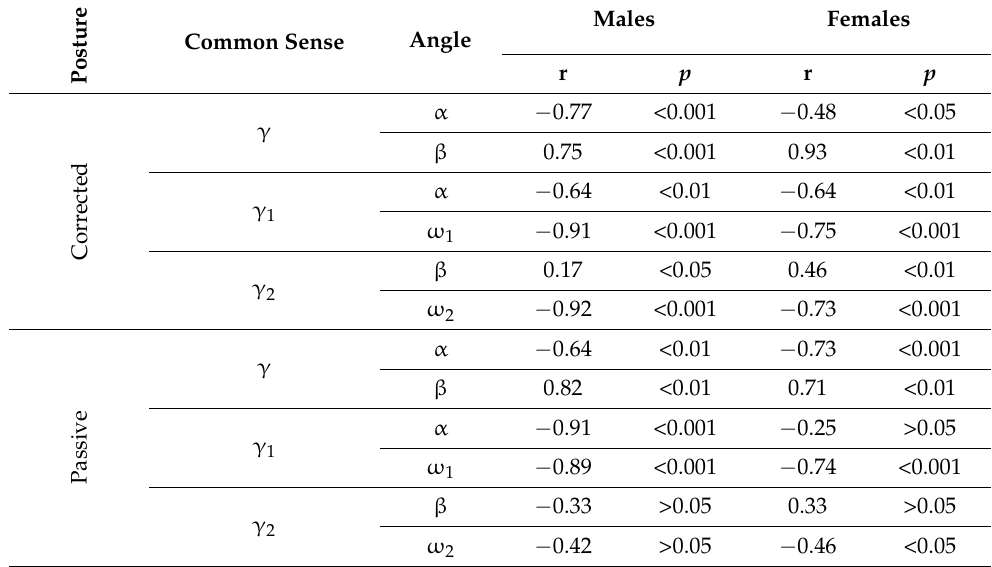
Table 4. Correlations between angles.